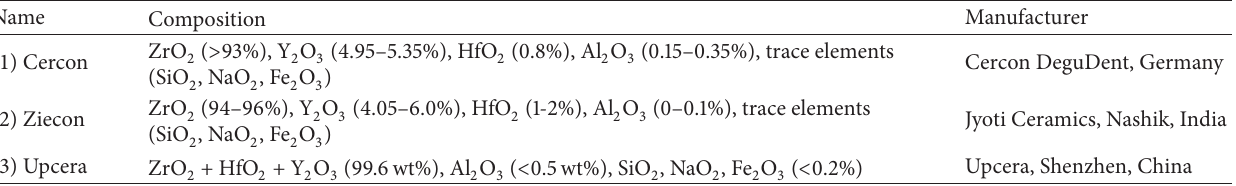
Table 1: Zirconia systems evaluated in this study.